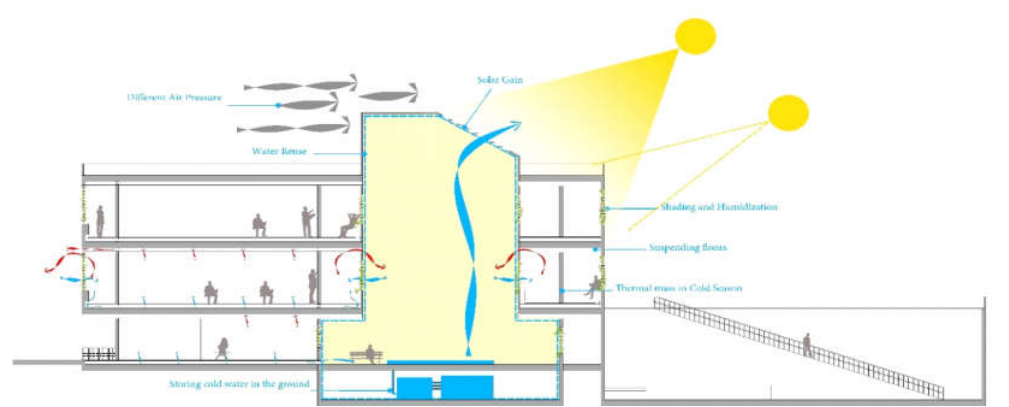
Fig. 3: Functional Diagram of the